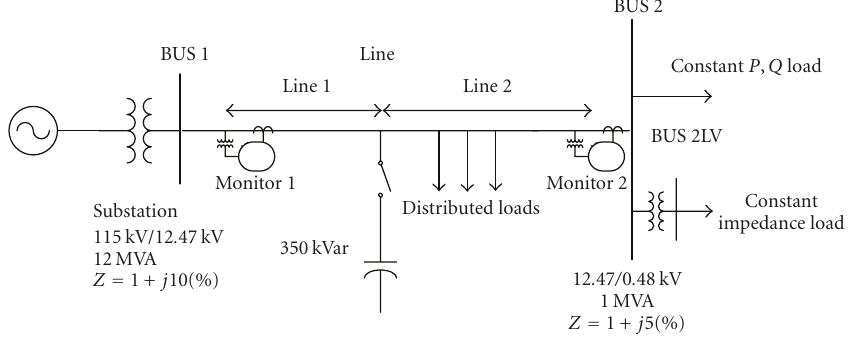
Figure 3: IEEE distribution system test case with modification and additional capacitor bank.